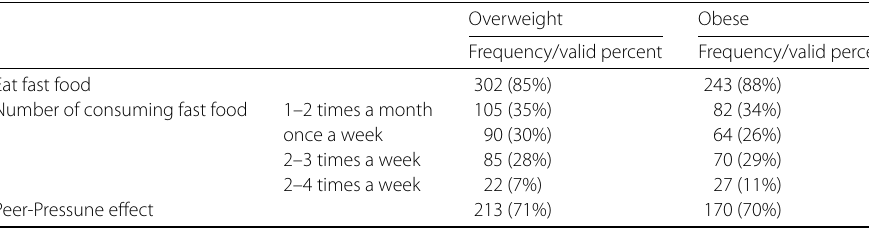
Table 3 Distribution of overweight / obese behavior of fast food consumption Overweight Obese Frequency/valid percent Frequency/valid percent Eat fast food 302